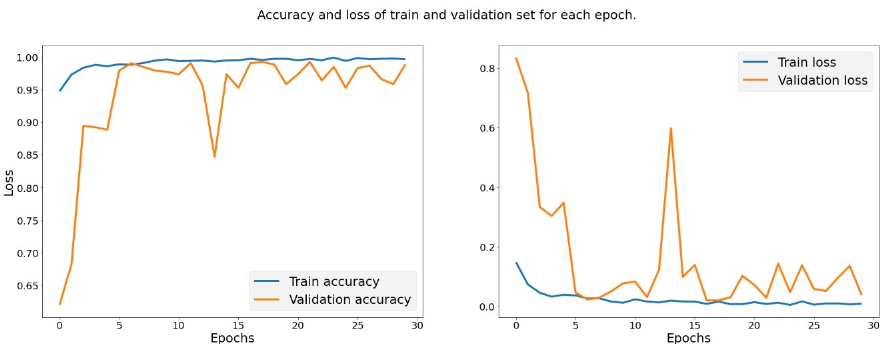
Figure 6. Evaluation of the training accuracy for Xception model.